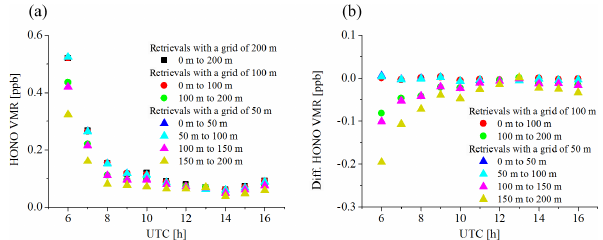
Figure 12. (a) Averaged diurnal variations of the HONO VMRs in the altitude range of up to 200m retrieved using the “PriAM” al- gorithm using vertical grid intervals of 50, 100, and 200m, respec- tively. Note that the results in the altitude grids below 200m are given, respectively. The results are derived from the HONO delta SCD measured by the MPIC instrument. (b) Averaged diurnal vari- ations of the differences of the HONO VMRs retrieved for vertical grid intervals of 50m and 100m compared to those retrieved for the vertical grid interval of 200m.